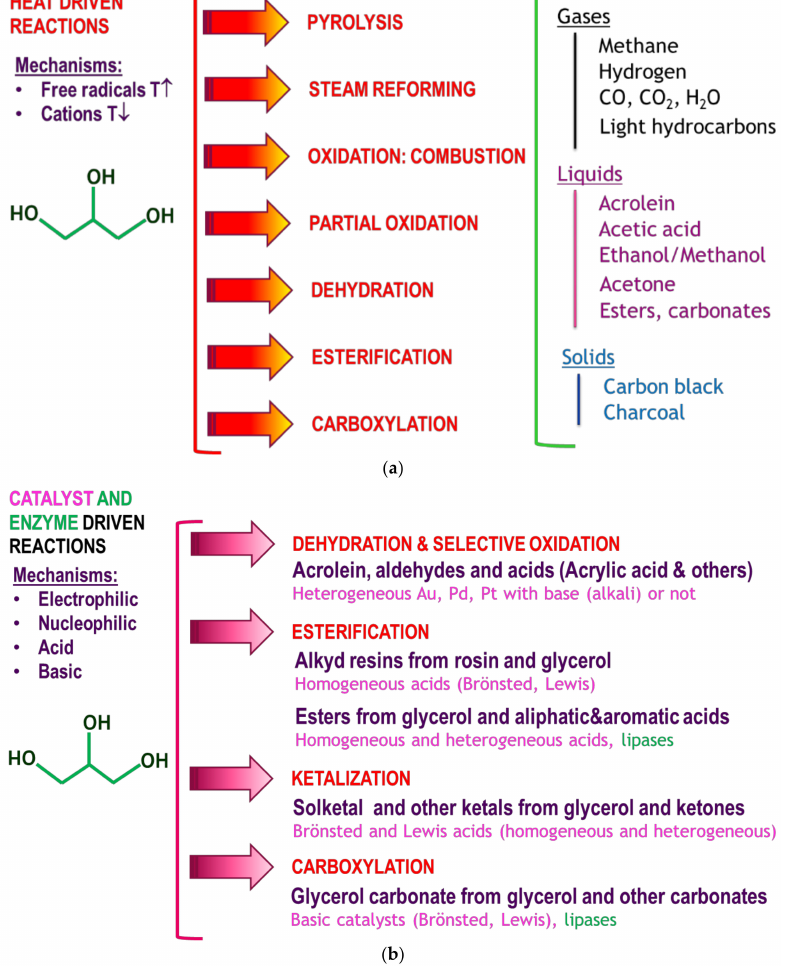
Figure 1. The glycerol biorefinery: several products obtained by thermal, catalytic and enzymatic